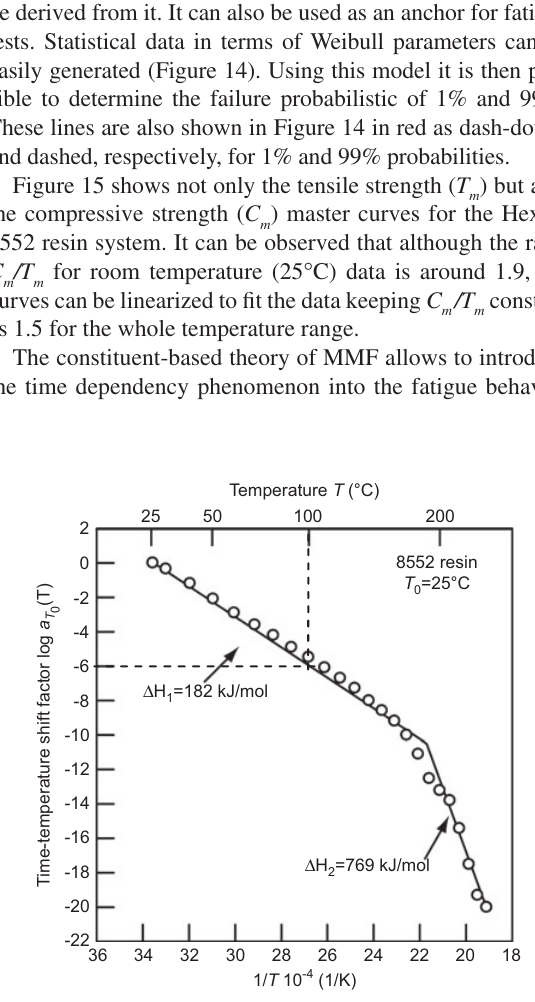
logarithm as a func- T 0